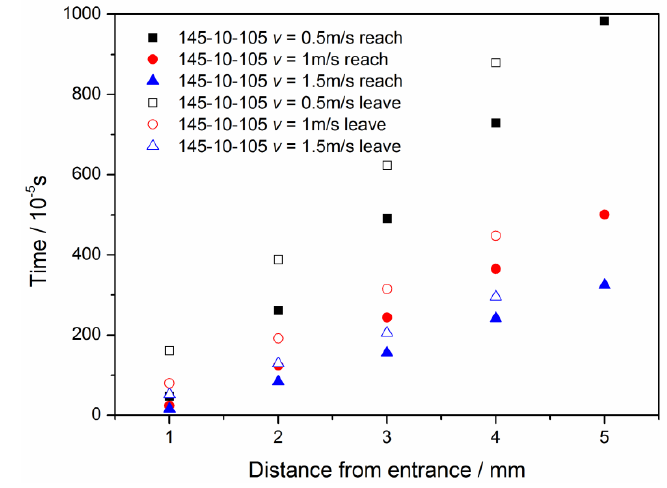
Figure 15. Comparison of times consumed with different initial velocities.